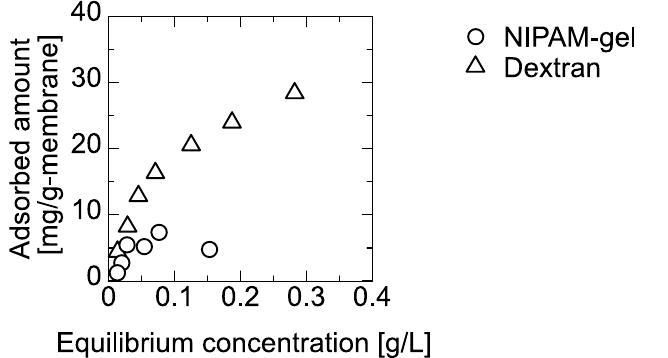
Figure 3. Batch mode adsorption of PNIPAM gel and dextran on the PE membrane at 303